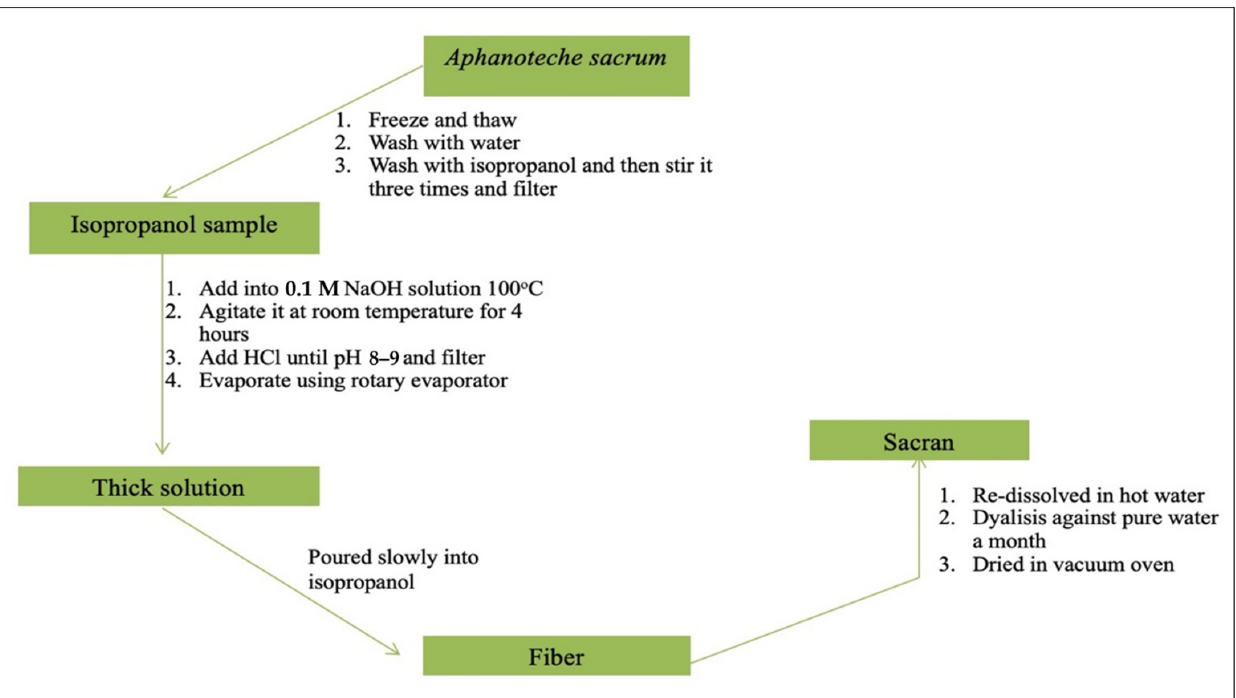
Figure 2. Scheme of sacran extraction process.